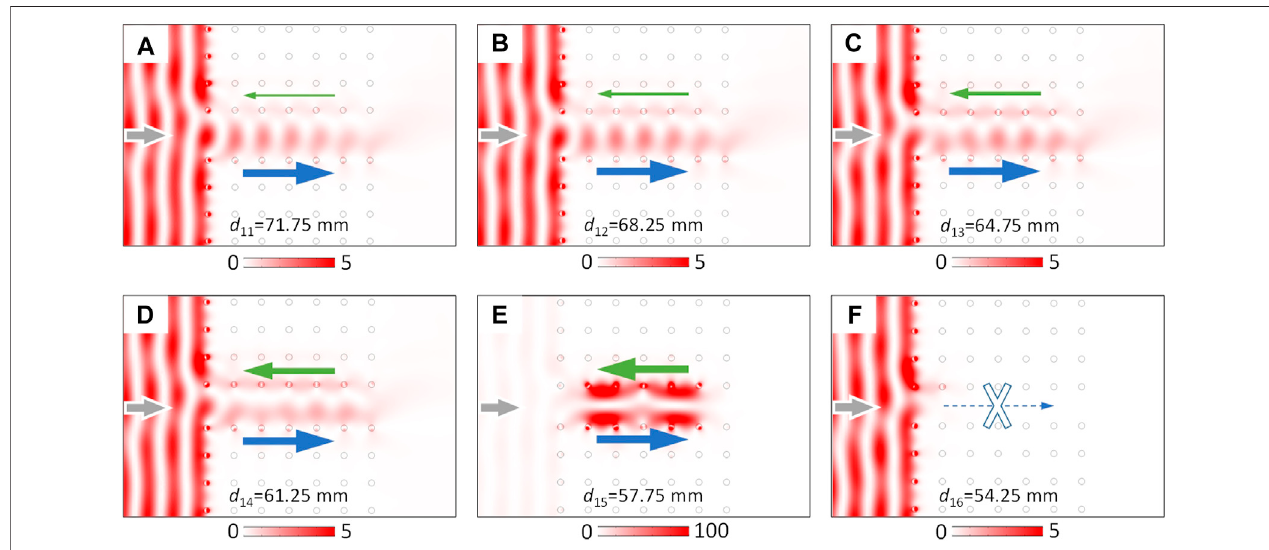
FIGURE3 | Electric fi eld distribution ofthe waveguide channel withdifferent waveguide widths. (A) d 11 (cid:1) 71.75mm, (B) d 12 (cid:1) 68.25 mm, (C) d 13 (cid:1) 64.75 mm, (D) d 14 (cid:1) 61.25 mm, (E) d 15 (cid:1) 57.75 mm, and (F) d 16 (cid:1) 54.25 mm. Theblue and green arrows indicate thetransportdirectionof thetopological one-wayedge states at the lower and upper edges, respectively. The thickness of the arrow represents the relative intensity of the electric fi eld between the lower and upper edges.